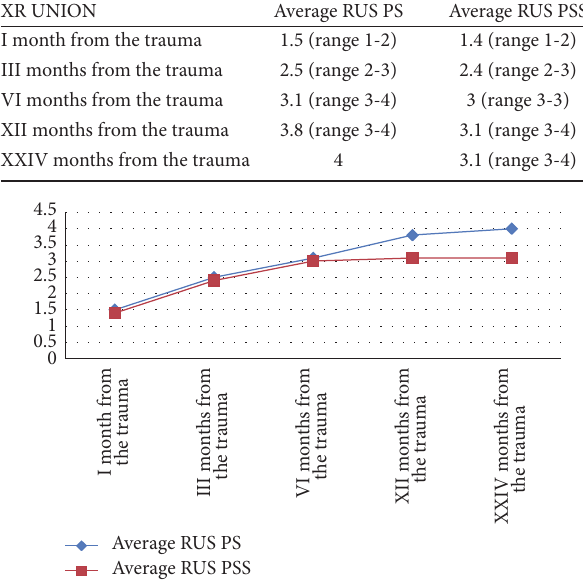
Figure 4: Trend of bone healing in two-year follow-up measured by Radiographic Union Score (RUS). At the twelfth month there was a statistically significant difference ( 𝑝 < 0.05 ) in favor of the PS